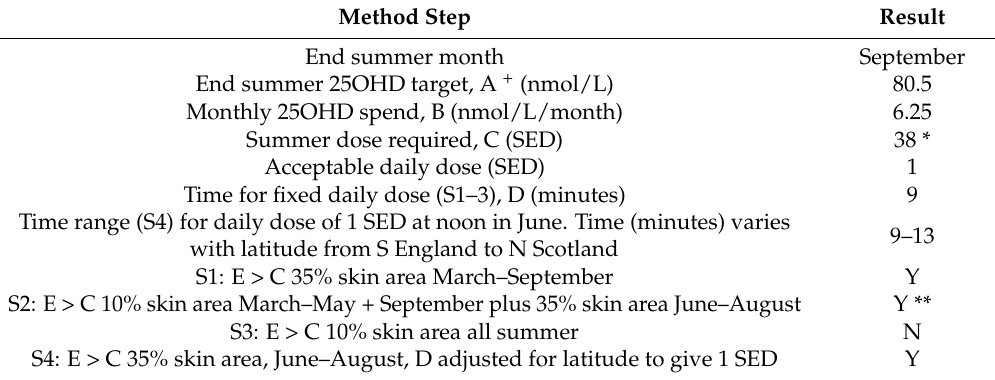
Table 3. The intermediate results (A–D from Figure 1) and final outcome of each scenario. E > C indicates that, by following the exposure scenario, a sufficient vitamin D level can be synthesized in the skin to maintain winter vitamin D status with 25(OH)D ≥ 25 nmol/L for 97.5% of the population.